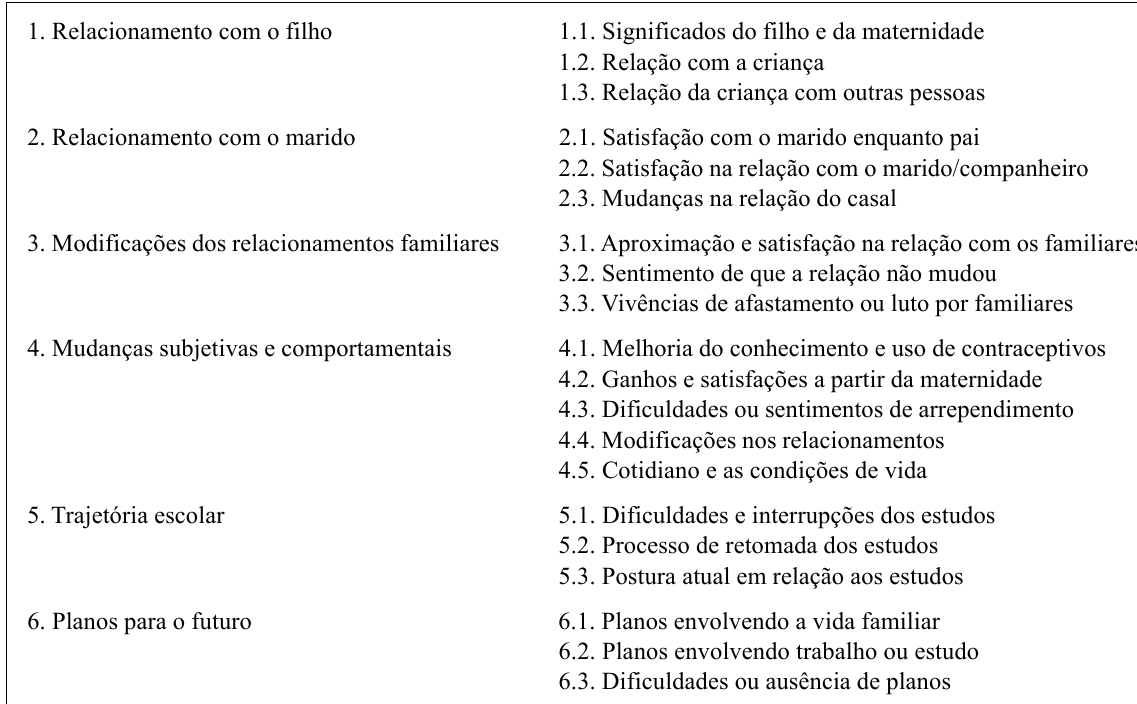
Figura 1 . Sistema de categorias e subcategorias de